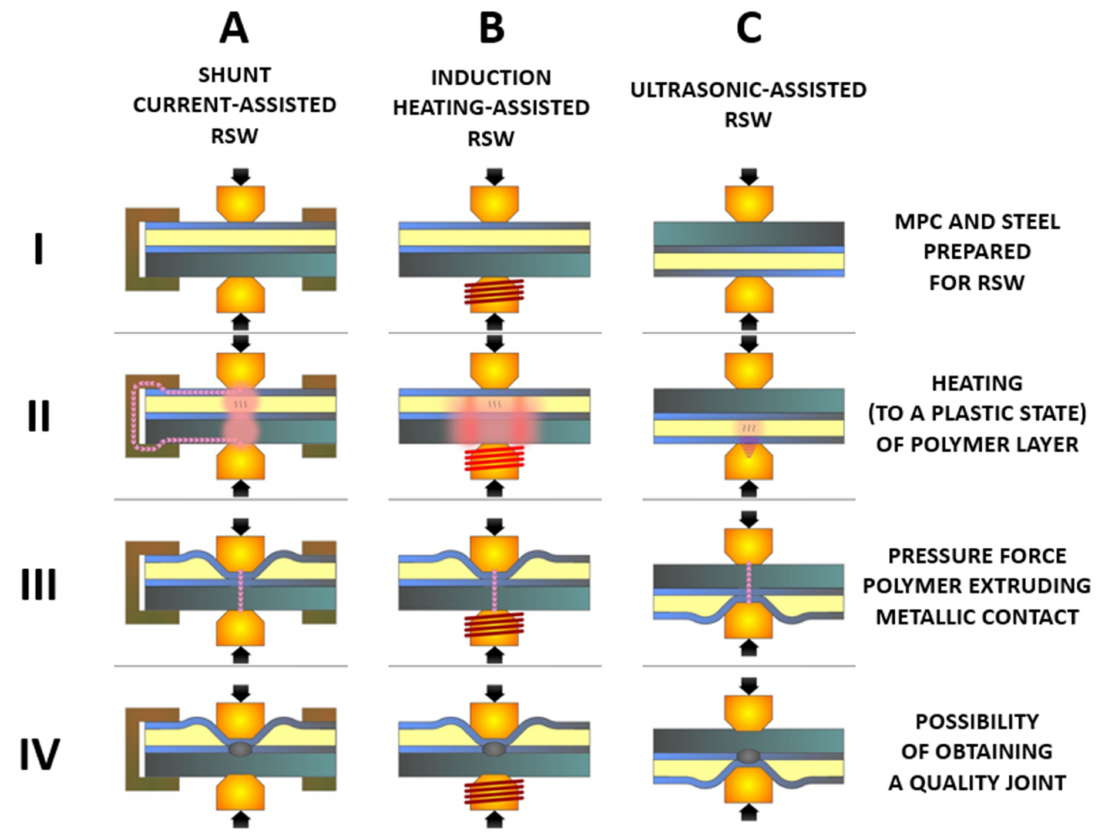
Figure 2. The schematic representation of the three concepts of RSW-assisted technology for MPC joining: ( A )—shunt current-assisted RSW; ( B )—induction heating-assisted RSW; and ( C )—ultrasonic-assisted RSW. Each process involves four stages (I to IV, described in the